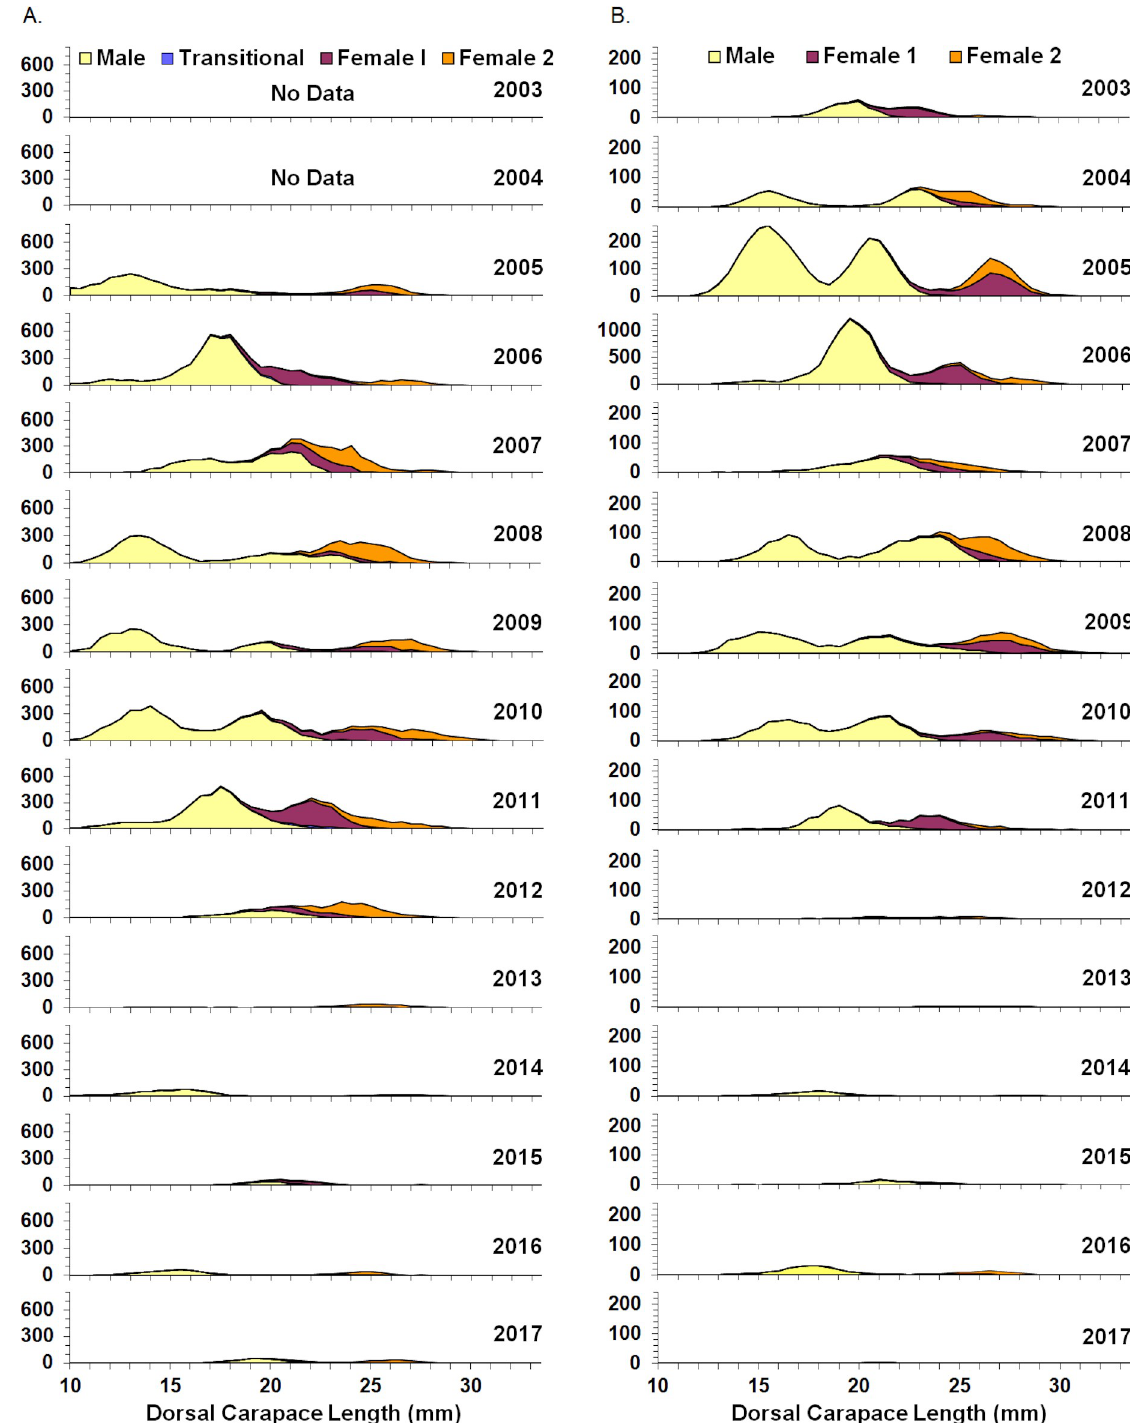
Fig 3. Stratified mean number per tow at length of northern shrimp by life history stage. (A.) spring inshore surveys, (B.) summer offshore surveys. Note change in summer offshore y-axis scale in 2006. Female 1 is first year breeding female, female 2 is second year breeding female, transitional is in process of changing from male to female. Life history stage data were not collected during spring inshore surveys until 2005.